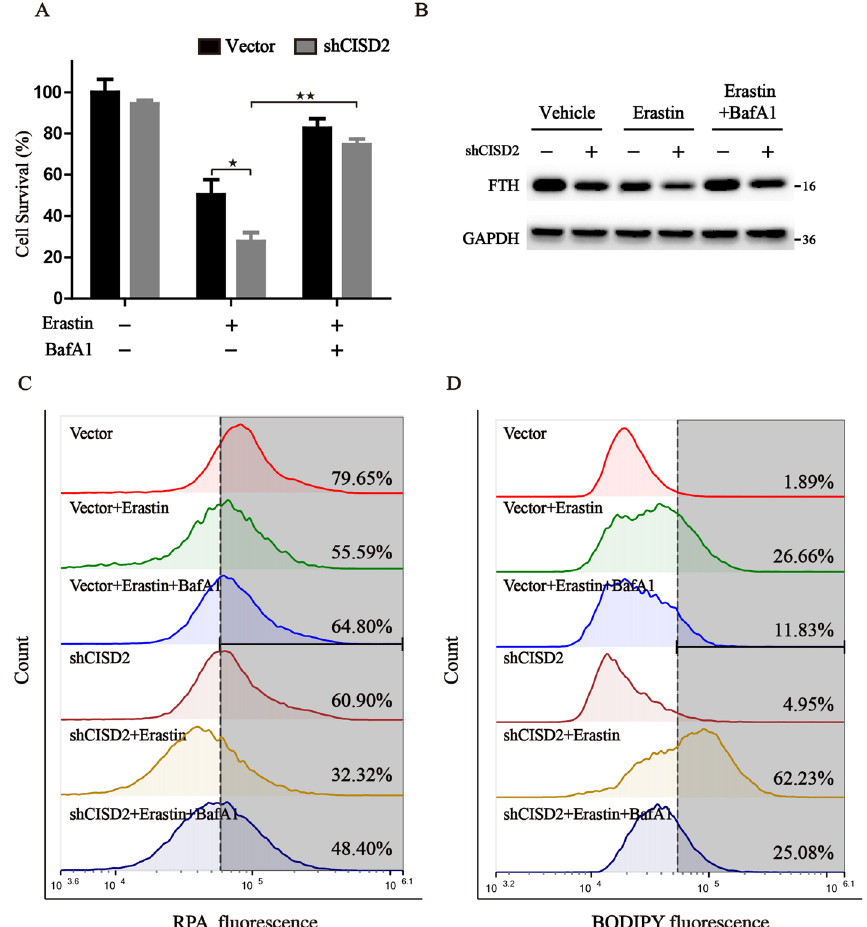
Fig. 3 Inhibition of autophagy hinders the process of ferritinophagy and ferroptosis induced by CISD2 knockdown. A Cell survival assay in control or CISD2-silenced HT-1080 cells under Erastin treatment (7.5 µM) with or without BafA1 (40 nM) co-treatment. B Western blot analysis of FTH expression on the condition of autophagy inhibition; GAPDH was used as loading control. C , D Representative images from flow cytometry for the detection of free iron and lipid peroxides by the staining of RPA and BODIPY, respectively; the intensity of RPA fluorescence was negatively correlated with iron accumulation, and the intensity of BODIPY fluorescence was positively correlated with lipid peroxides. ★ P < 0.05 and ★★ P < 0.01 between the indicated